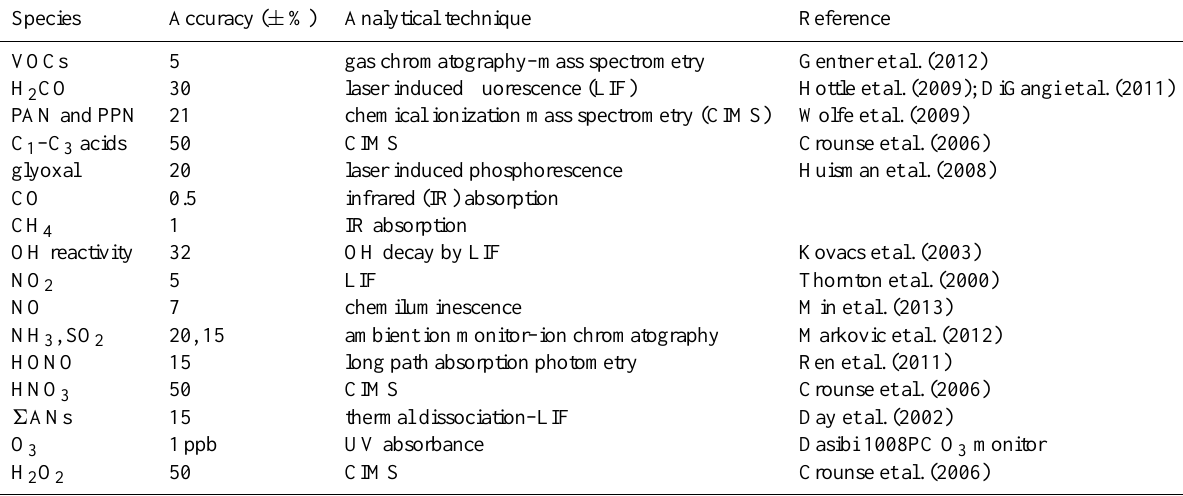
Table B1. Species, measurement accuracy, analytical technique, and reference for each CalNex-SJV observation included in our analysis. Many species are measured with higher precision than accuracy. See original references for details. All CalNex data are accessible to